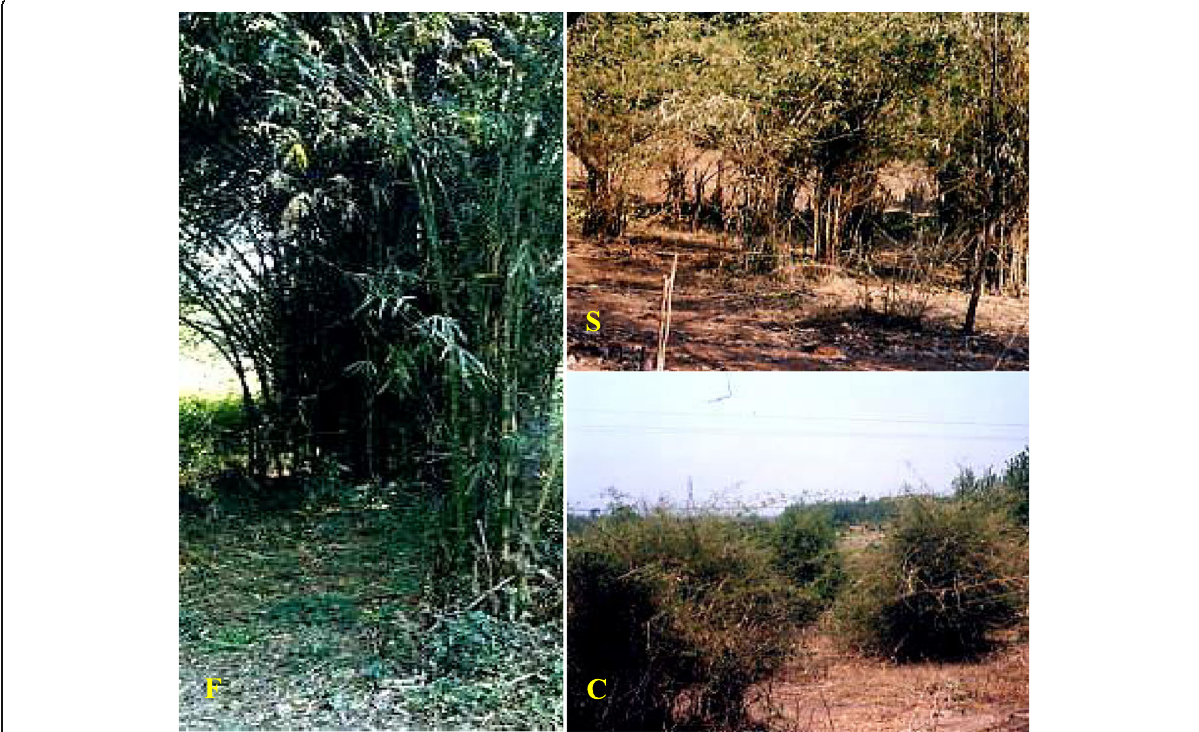
Fig. 2 General views of Dendrocalamus strictus growth forms at different locations in Uttarakhand. Dendrocalamus strictus at FRI campus (F), near Byasi in Shivpuri range (S) and Chiriapur range (C). Source: Rawat,